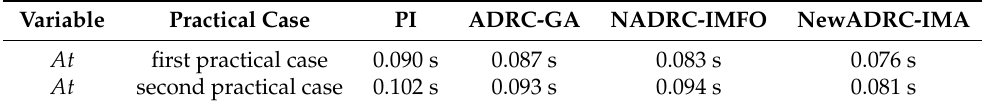
Table 4. The adjusting time for each practical